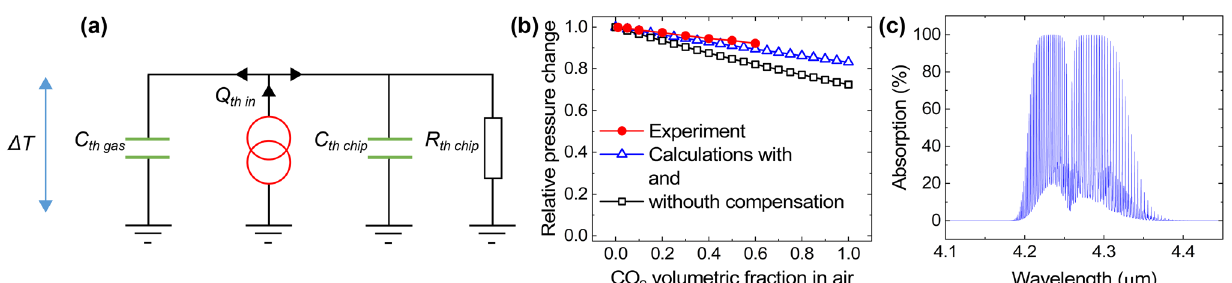
Figure 2. Sensor interfacing. ( a ) Block diagram of the experimental setup. The microheater is electrically modulated using a custom current drive circuit. Signals from the active and reference MEMS microphones are amplified and their differential signal digitised using a National Instruments data acquisition unit, with a software based lock-in amplifier used to help remove noise. ( b ) Modulated acoustic signal showing the pressure changes which occur during electro-thermal modulation of the sensor at a frequency of 43 Hz. ( c ) Acoustic frequency response of the sensor, showing the rise in the acoustic signal with modulation frequency and gradual tail off in the response due to thermal inertia of the membrane which limits the thermal modulation depth. Inset: relative change in pressure with humidity. ( d ) Response of the sensor to pulses of ~ 20–60 % CO 2 gas concentrations showing the drop in the thermal acoustic signal with increasing CO 2 concentration.